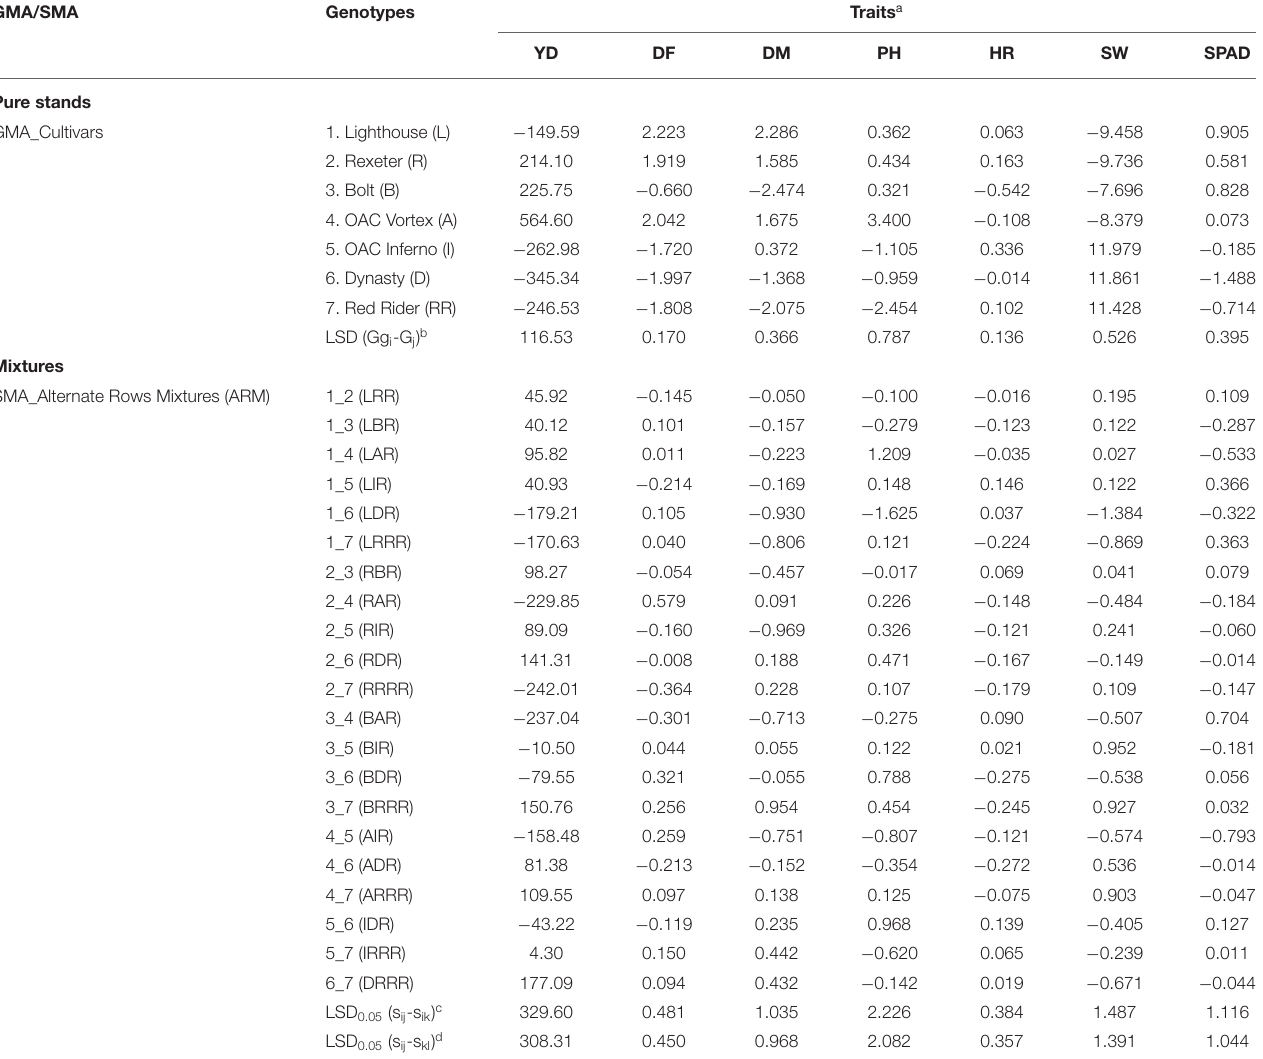
TABLE 6 | Estimated general mixing ability (GMA) for traits analyzed in seven bean genotypes and specific mixing ability (SMA) of their same row binary mixtures (ARM) averaged over three Ontario environments/locations in 2018.